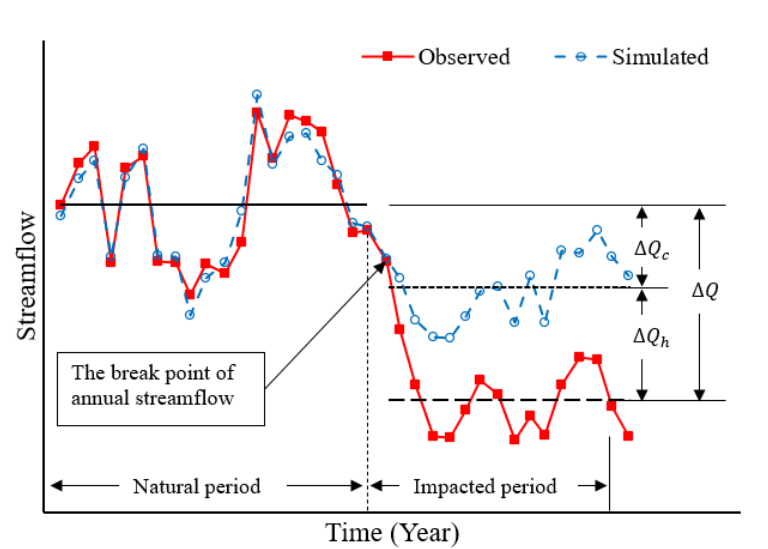
Figure 3. The framework for quantitative evaluation of the runoff decrease based on the model simulation (modified from Bao et al. [9]).